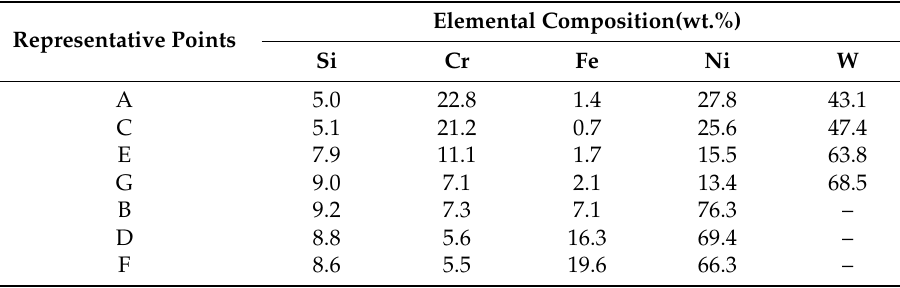
Table 4. Composition of points marked in Figure 8.